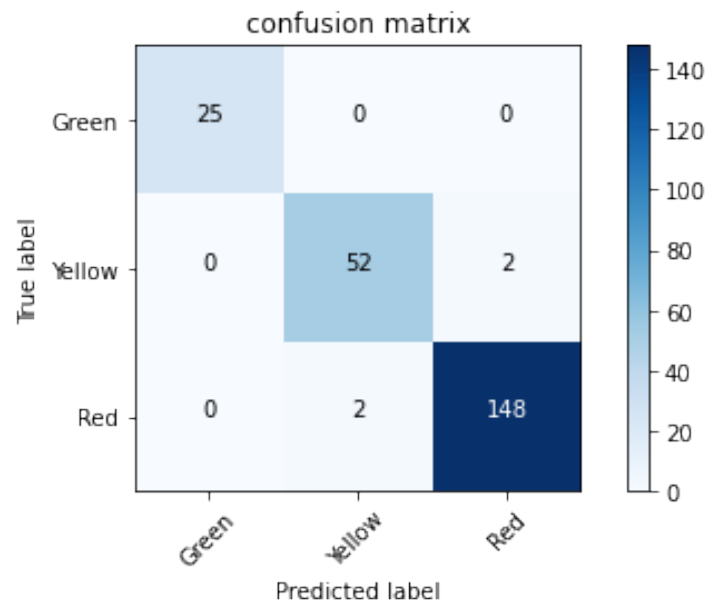
Figure 6. ANN confusion matrix on test-set.